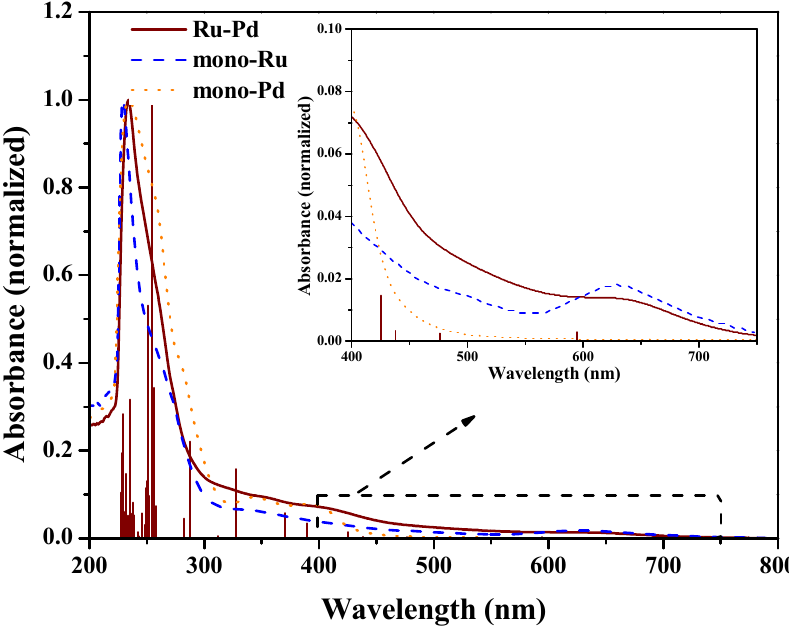
Figure 2. Electronic absorption spectra of mono-Ru (blue dashed line), mono-Pd (orange dotted line), and Ru–Pd (marron solid line) and experimentally calculated oscillator strength (f) (dark red vertical lines) for Ru–Pd. Conditions: [Ru/Pd] = [mono-Ru] = [mono-Pd] = 1.0 × 10 − 4 mol L − 1 ; CH 2 Cl 2 as solvent, at 25 °C.